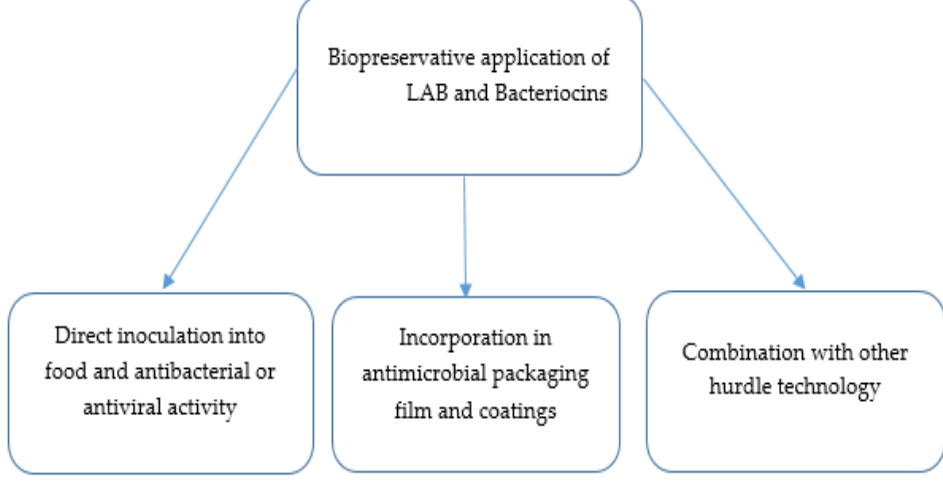
Figure 1. Modes of applications of bacteriocins in the control of foodborne pathogens. Strains of Lactobacillus casei isolated from Iranian traditional yoghurts showed potential activity against enteropathogenic E. coli and Salmonella spp . [53]. Djadouni and Kihal [19] screened LAB from dairy, meat products and agro-industrial wastes and isolated a LAB strain (LBbb0141) that contained antimicrobial compound with a wide spectrum and was inhibitory to ten indicator Gram-positive and Gram-negative